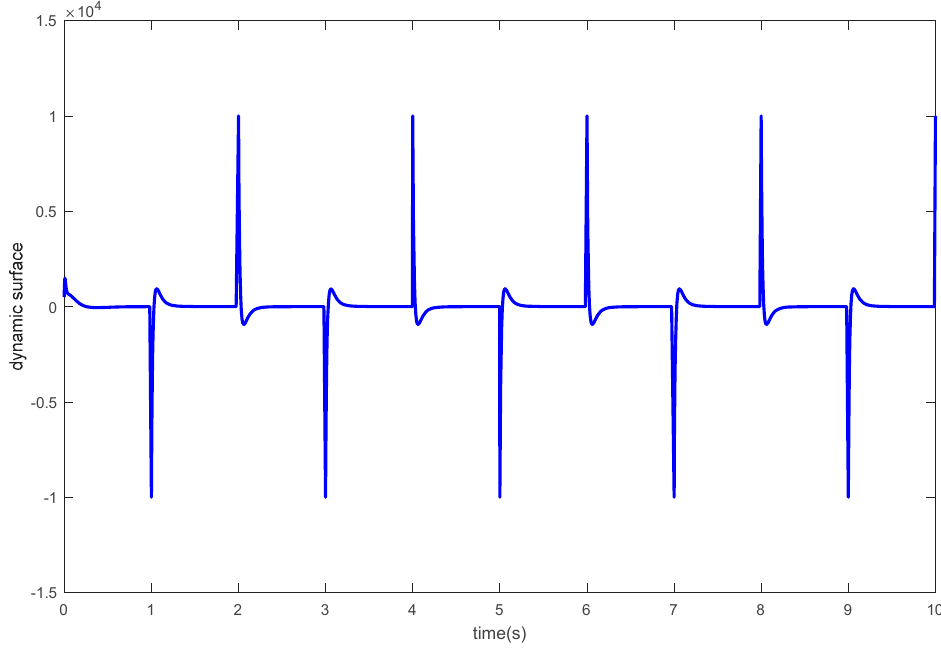
Figure 14. Time response of dynamic surface.